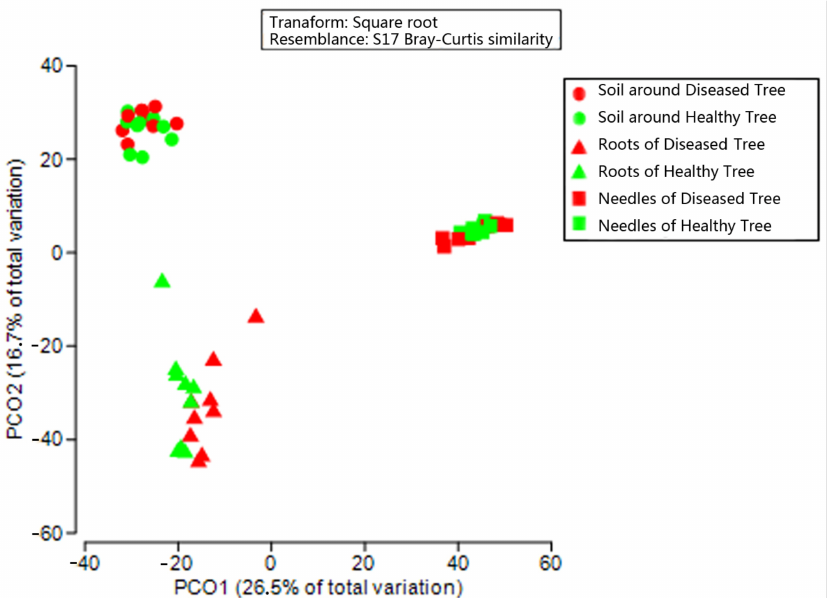
Figure 3. Principal-coordinate analysis (PCoA) showing fungal community structure in soil, roots, and needles around and of healthy and diseased trees.